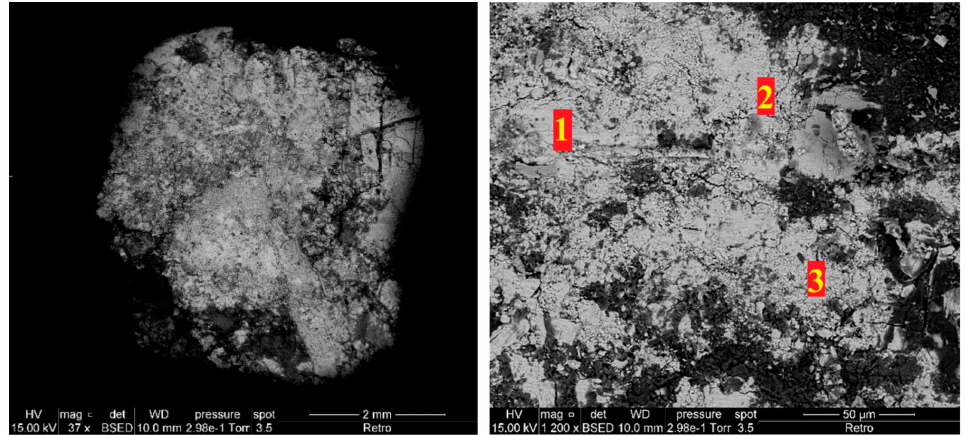
Figure 14. SEM images of Si-Ge-La after thermal treatment at 1500 ◦ C. Table 9. EDX results of light zones of Si-Ge-La after thermal treatment. Element Light Zone 1 Light Zone